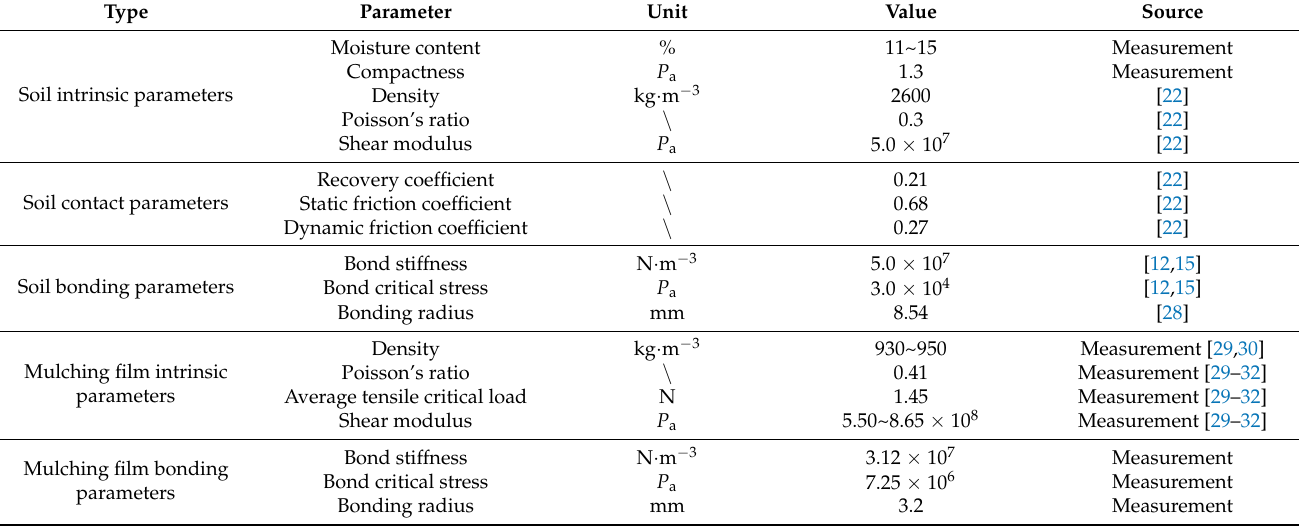
Table 1. Main parameters of discrete element